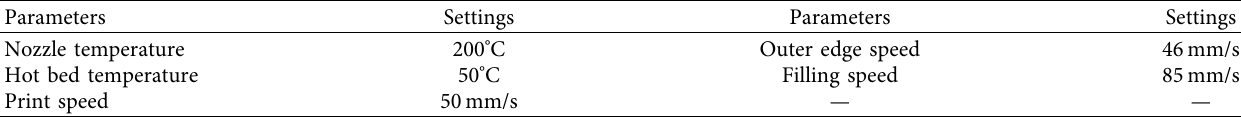
Table 1: Printer parameters.